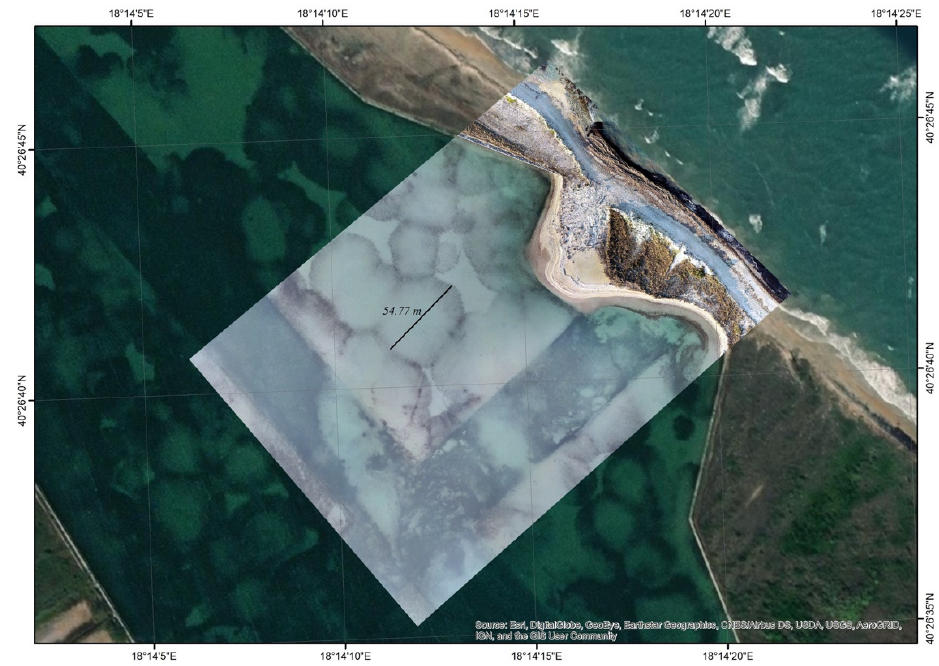
Figure 11. Detailed image of a part of Acquatina di Frigole lagoon. The image processing consisted of four steps, with Structure-from-motion (SfM) and Multi-View Stereo Reconstruction (MVS) being fundamental (step 1); this is the crucial moment for calibration and image processing (the time- consuming step), when the geometry of the substratum is reconstructed and processed in a dense point cloud. Mesh reconstruction is step 2: starting from the dense point cloud, a continuous surface is built composed of polygons in which the vertices are the dots of the dense point cloud. Mesh colour application (step 3): basically, the mesh has no colour attribute, so the colour can be attributed as colour-per-vertex (the dense point cloud colour is transferred to the mesh polygons) or texture mapping (the images acquired during the survey are applied to the mesh polygons). 3D model (step 4): the model is scaled using at least one Ground Control Point (GCP) because the software cannot deduce the size of the objects in the pictures.